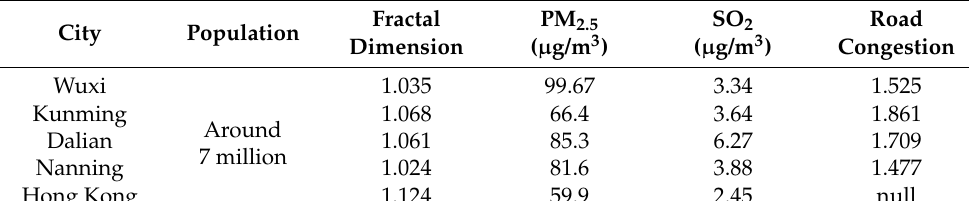
Table 4. PM 2.5 and road congestion indexes of cities with similar urban population sizes.